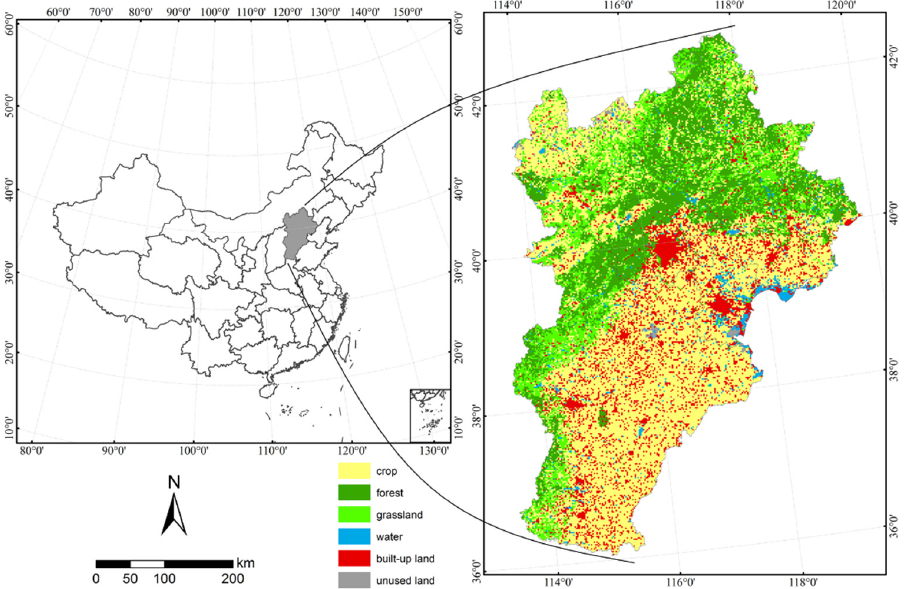
Figure 1. Location of the study area in 2015.